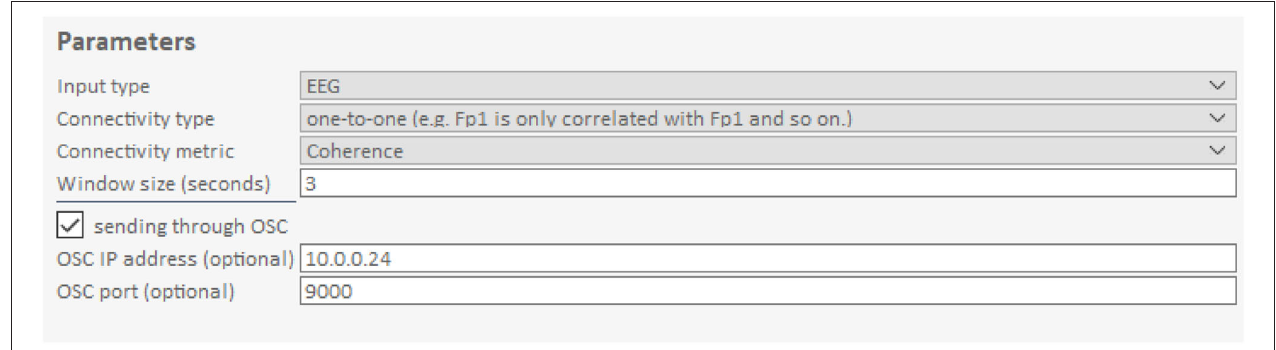
FIGURE 5 | Connectivity parameters of the Hybrid Harmony GUI. The upper right part of the GUI, i.e., the “Parameters” control parameters for connectivity analysis (section Connectivity Analysis). Input type specifies the type of data (here: EEG). Connectivity Type determines how the connectivity values are averaged across electrode pairs. Connectivity metric determines the calculation of synchrony between two signals. Window size is the length of the data segment to compute synchrony over online. The checkbox sending through OSC determines whether connectivity values are sent through OSC ( Supplementary Material , The Data Transfer Protocol: Open Sound Control) in addition to LSL. OSC IP address and OSC port are used to transport